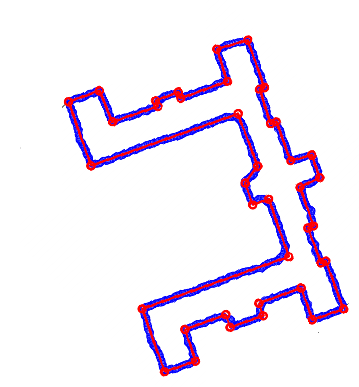
Figure 6: Approximation of polygon obtained using RANSAC